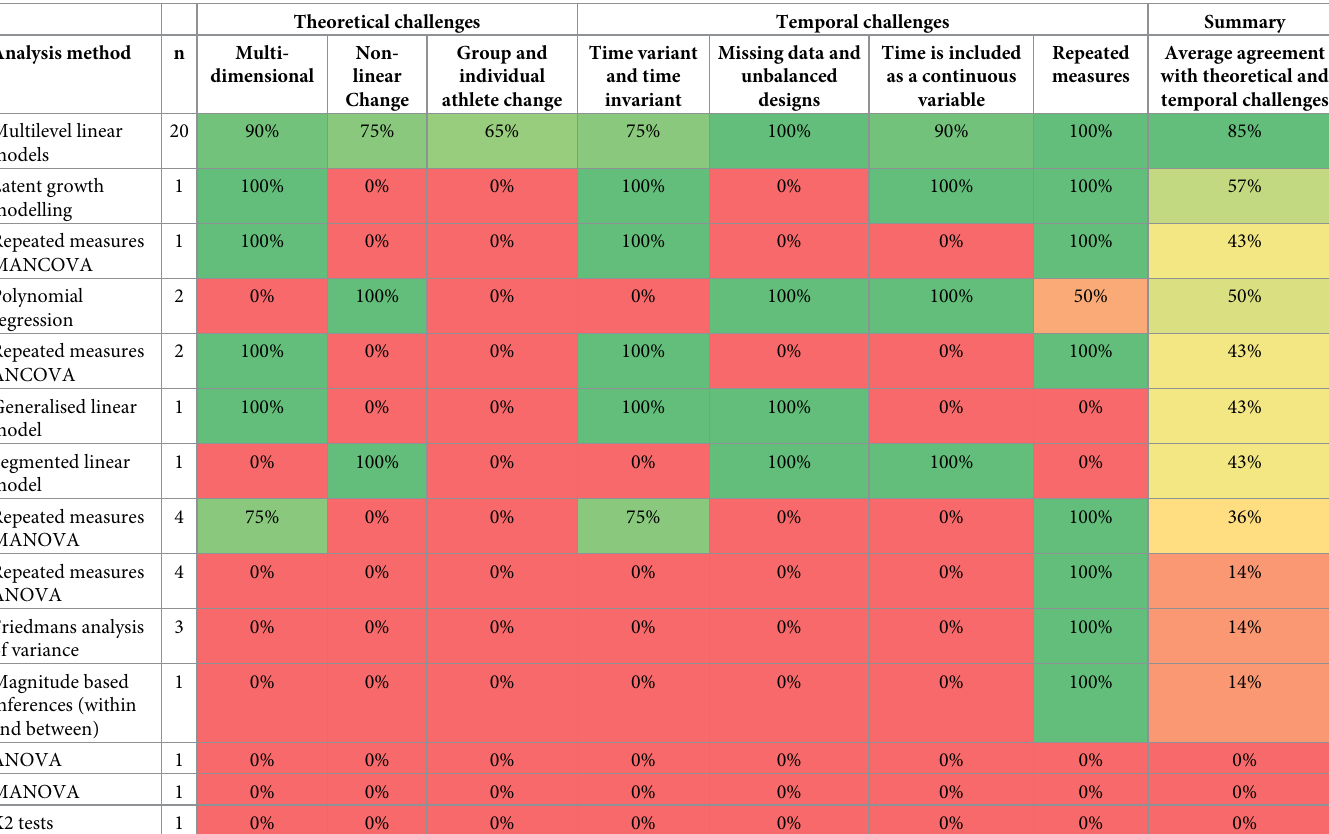
Table 6. A qualitative assessment of the ability of statistical methods to meet the theoretical and temporal challenges faced when evaluating longitudinal fitness testing